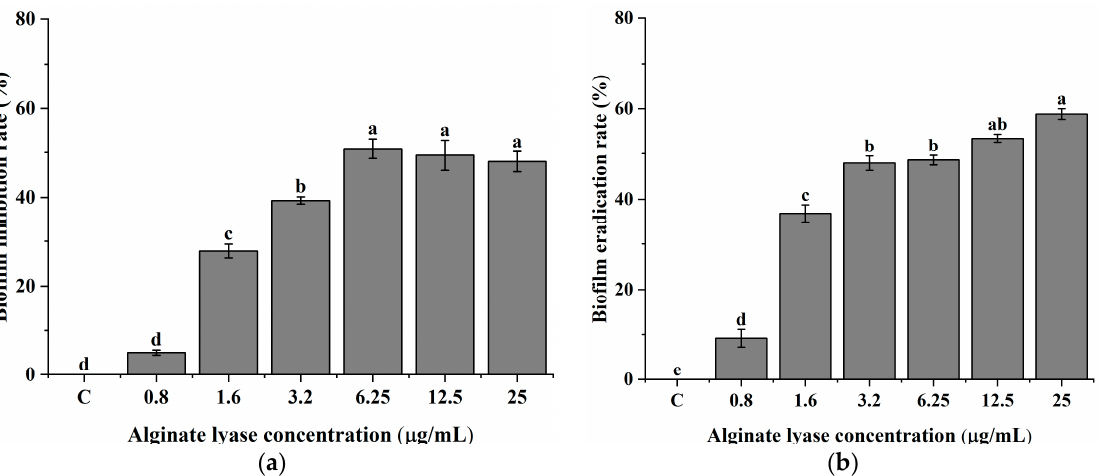
Figure 2. Dose–response of P. aeruginosa PAO ‐ 1 biofilm formation inhibition ( a ) and disruption of biofilm biomass ( b ). The means with the same superscript are not significantly different, with p > 0.05. Error bars represent standard deviation.